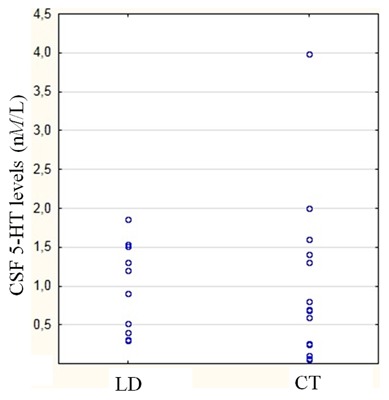
The graph shows the individual 5-HT concentration levels, comparing PD patients under LD alone (LD, n = 10) and DA plus LD (CT, combined therapy, n = 15).The difference is not significant. Not included, due to exiguity of the samples, the values of denovo (n = 6) and patients under DA alone (n = 4). To note, any therapy regards the period preceding the 3-days washout implicit to the study.